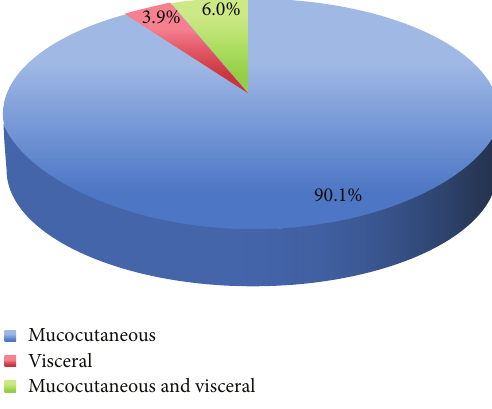
Figure 3: Anatomic distribution of KS